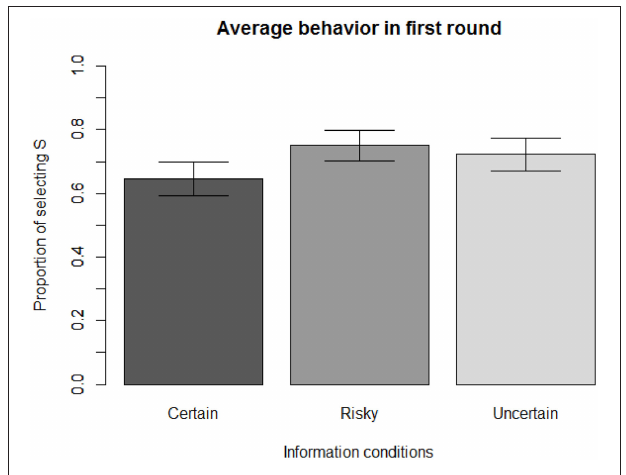
FIGURE 4 | Average initial behavior across information conditions.